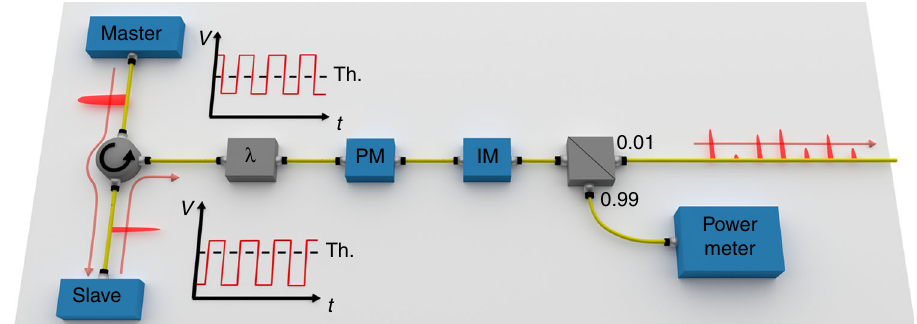
Fig. 2 Transmitting module. Two replicas of the depicted fi bre-based setup are used by Alice and Bob to transmit light pulses to Charlie. Master and slave lasers ’ driving signals are displayed alongside the equipment and are set differently for the two lasers. A power metre connected to the output beam splitter attenuates the outgoing optical pulses to the correct level. The wavelength fi lter ( λ ) is for enhancing the indistinguishability of Alice ’ s and Bob ’